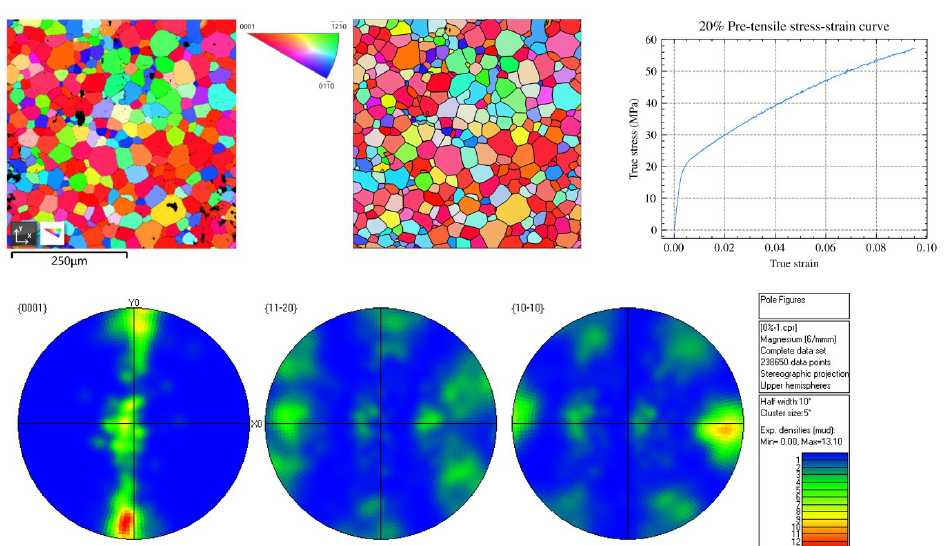
Figure 1. The inverse pole figure and the pole figure of the initial microstructure prior to deformation. Furthermore, the pre-tensile stress–strain curve under 20% tensile